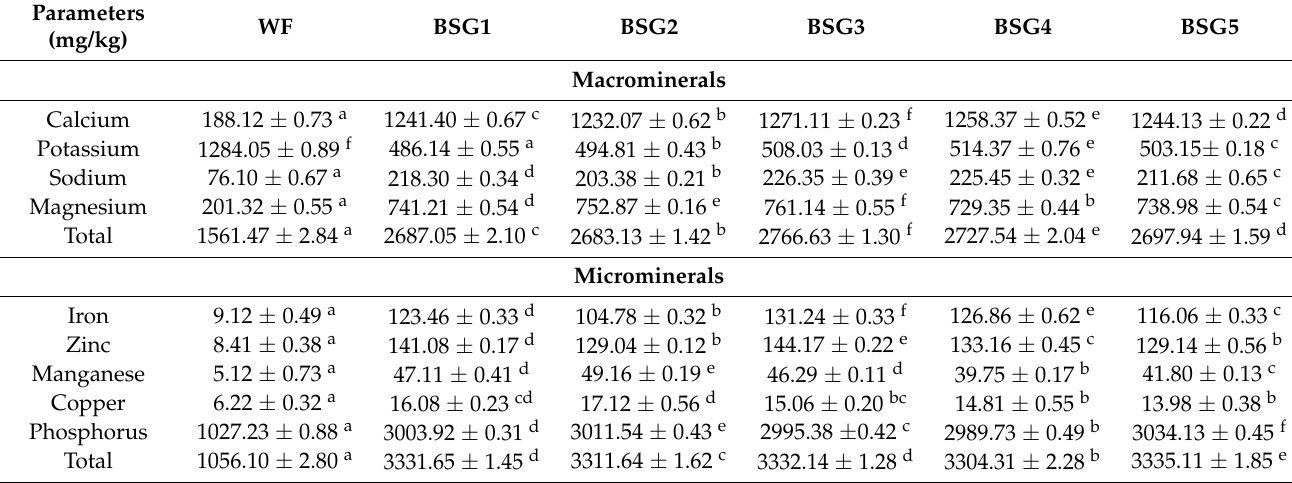
Table 3. Mineral’s content of dried BSG (brewers spent grains) and WF (wheat flour)